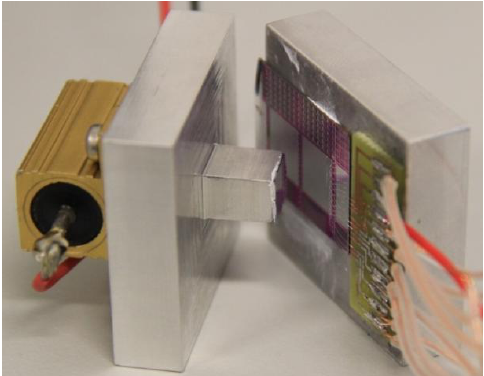
Figure 4. Picture of the measurement set up used for the characterization of the thermoelectric generator, depicting the top Al bath metal with the external resistor attached on it and the Al-coated TEG die.